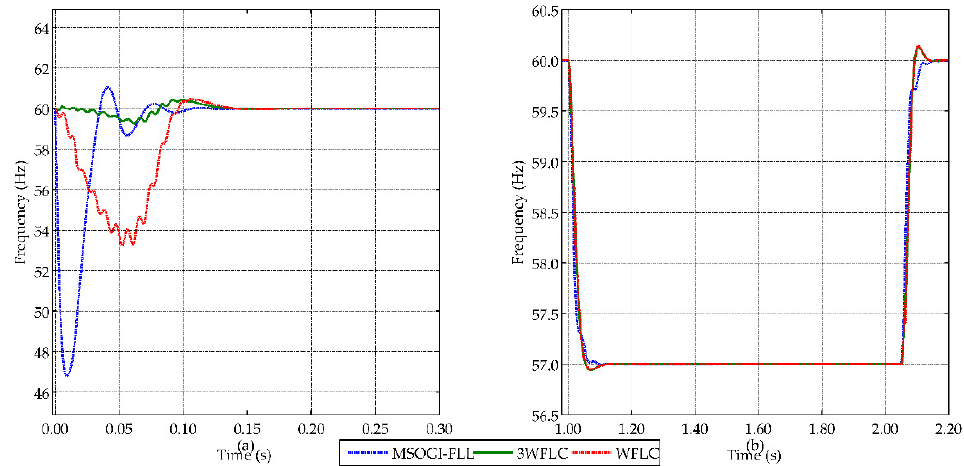
Figure6. Resultsfromscenario4, frequencyvariation. ( a )Suddenvoltageinput; ( b